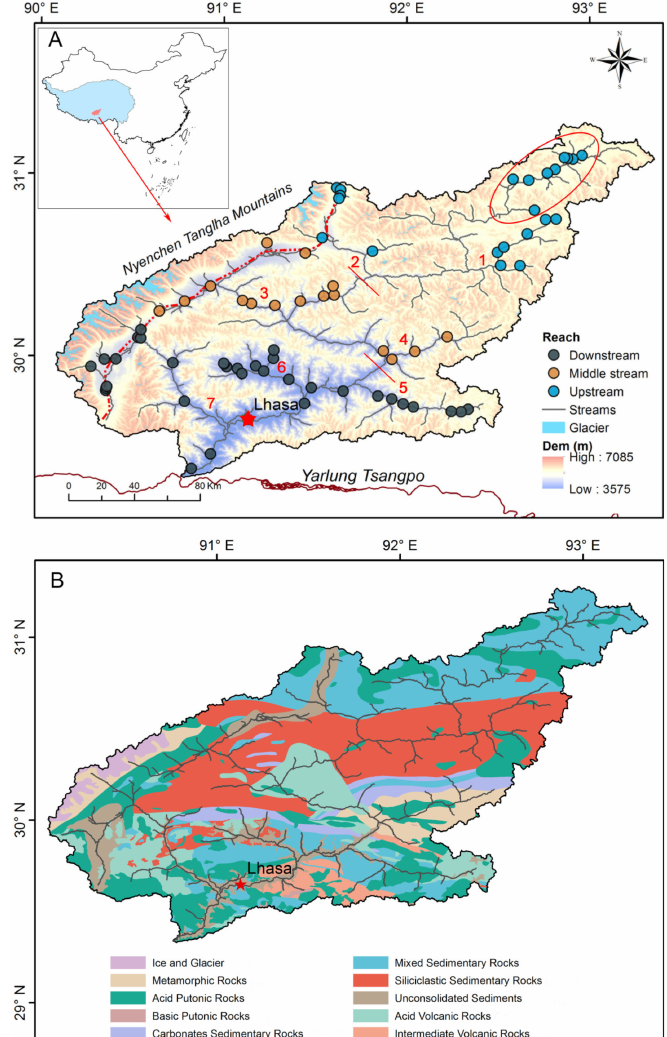
Figure 1. Location of the Lhasa River basin. ( A ) The sampling sites (marked by solid circles) during the rainy and dry seasons. The red short lines are nodes that divide the LR channel into the upstream, middle stream, and downstream, respectively. The red ellipse means the source area of the LR. The red numbers mean the tributaries of the Lhasa River, which are: 1 Maiqu; 2 Sangqu; 3 Wululongqu; 4 Xuerong Tsangpo; 5 Mozhuqu; 6 Pengboqu; 7 Duilongqu. The red dashed line is the geothermal water distribution zone. ( B ) Lithological map of the Lhasa River basin. The lithology data was obtained from the global lithological map